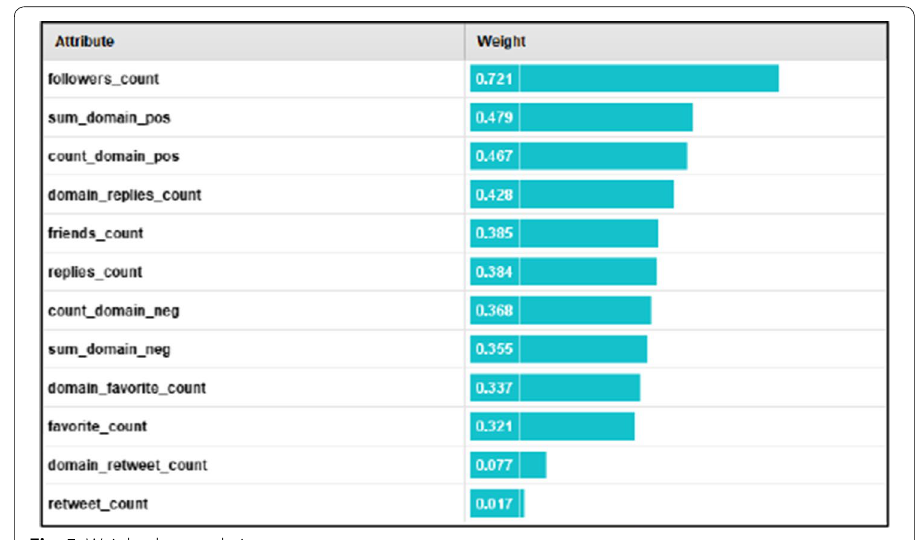
Fig. 5 Weights by